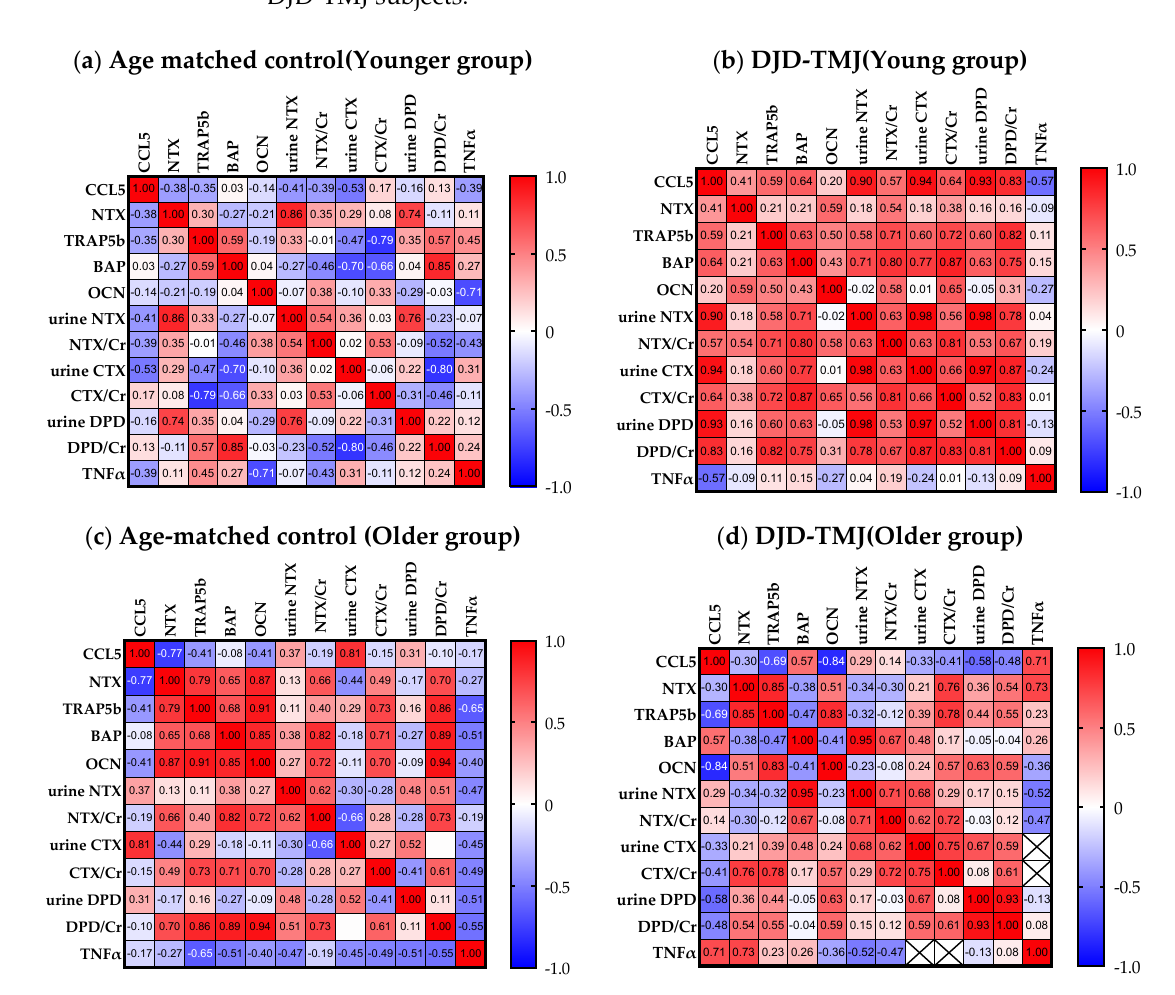
Figure 5. Multivariate analyses between molecules in ( a ) the control group at ≤ 42 years old (n = 11) and ( b ) the group of all DJD-TMJ subjects at ≤ 42 years old (n = 10), ( c ) the control group at >42 years old (n = 6) and ( d ) the group of all DJD-TMJ subjects at >42 years old (n = 7). The color depth of red and blue indicates the degree of positive and negative associations, respectively, between indicated molecules.